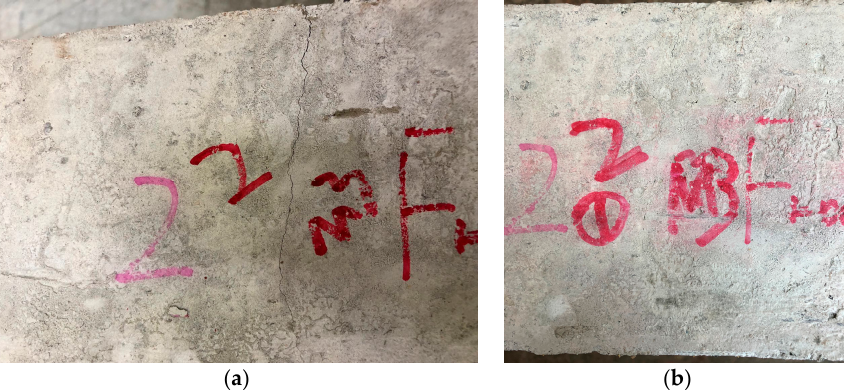
Figure 1. Self-healing of crack ( a ) initial crack; ( b ) healed crack after 4